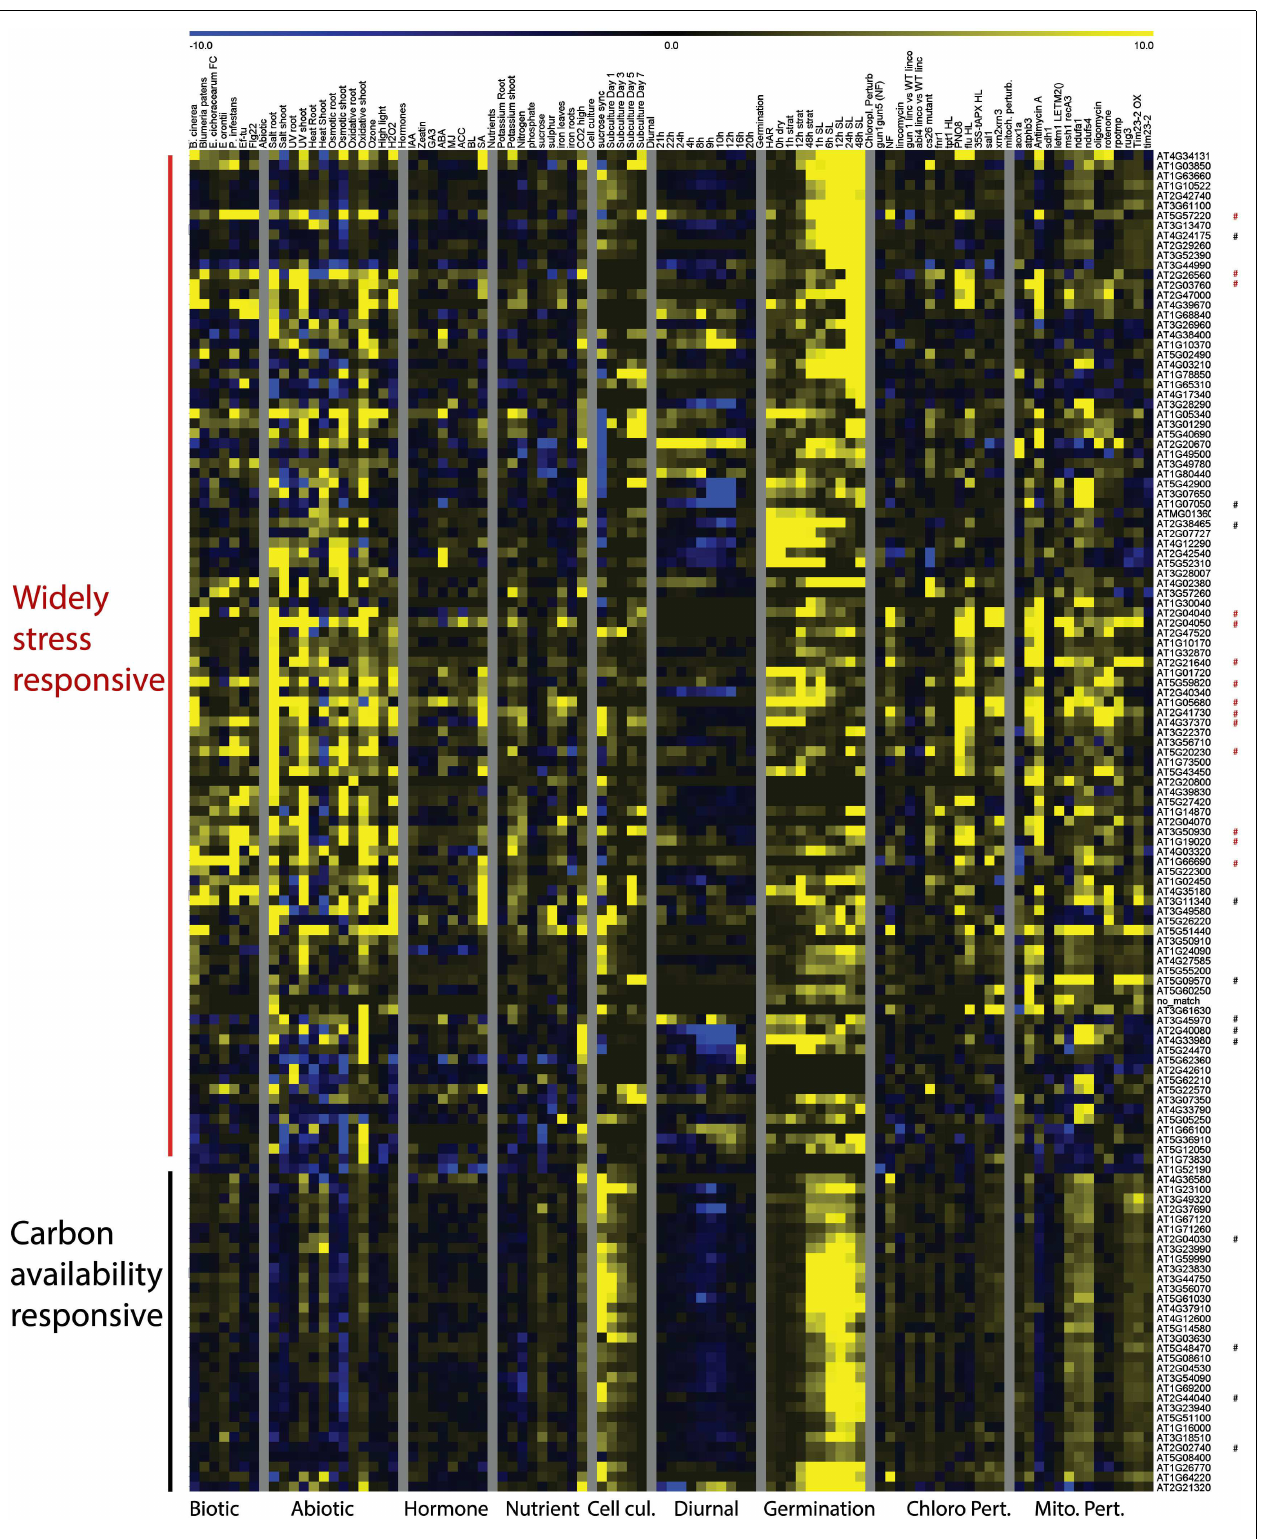
sets that were also commonly altered by chloroplast perturbations, black asterisks indicate probe sets that were specifically responding to mitochondrial perturbations. Abbreviations: Cell cul, cell culture; Developm, development; Germin, germination; Chloro Pert, chloroplast perturbation; Mito pert, mitochondrial